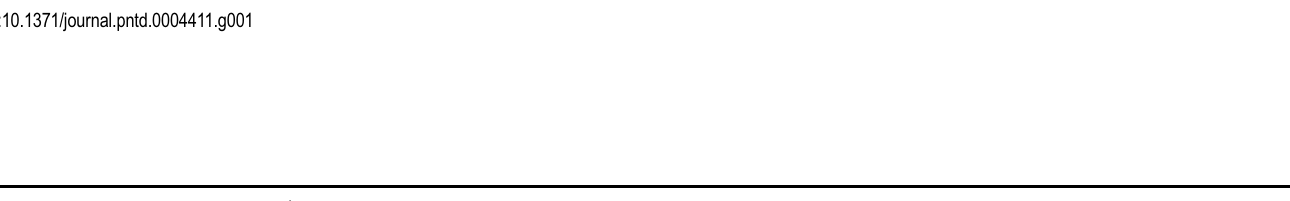
PLOS Neglected Tropical Diseases | DOI:10.1371/journal.pntd.0004411 February 1,